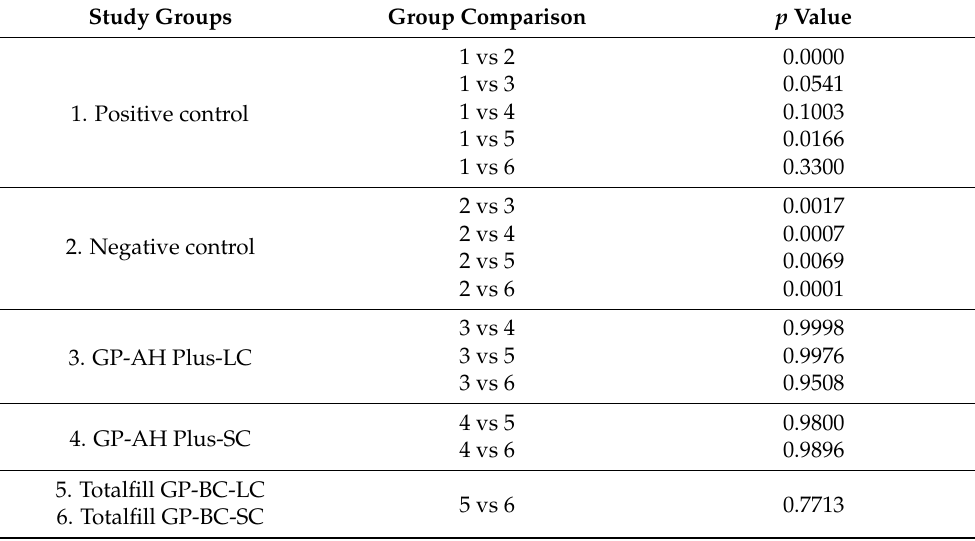
Table 2. Statistical comparison of root fracture resistance among study groups (Tukey’s post hoc